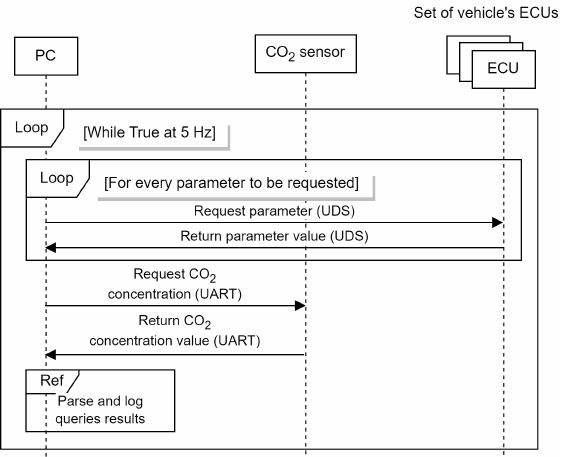
Figure 2. Data collection sequence diagram. Notice that after the acquisition of every ECU parameter and the CO 2 concentration, the received messages have to be re-scaled and transformed from hexadecimal to decimal